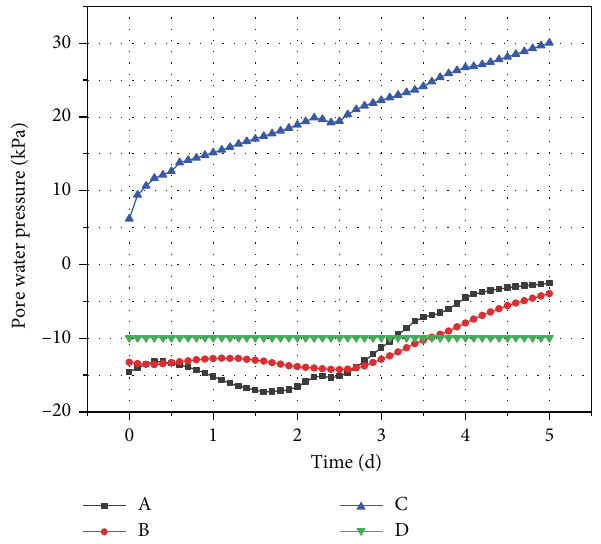
Figure 7: Variation of pore water pressure at each monitoring point in slope in coupling case.